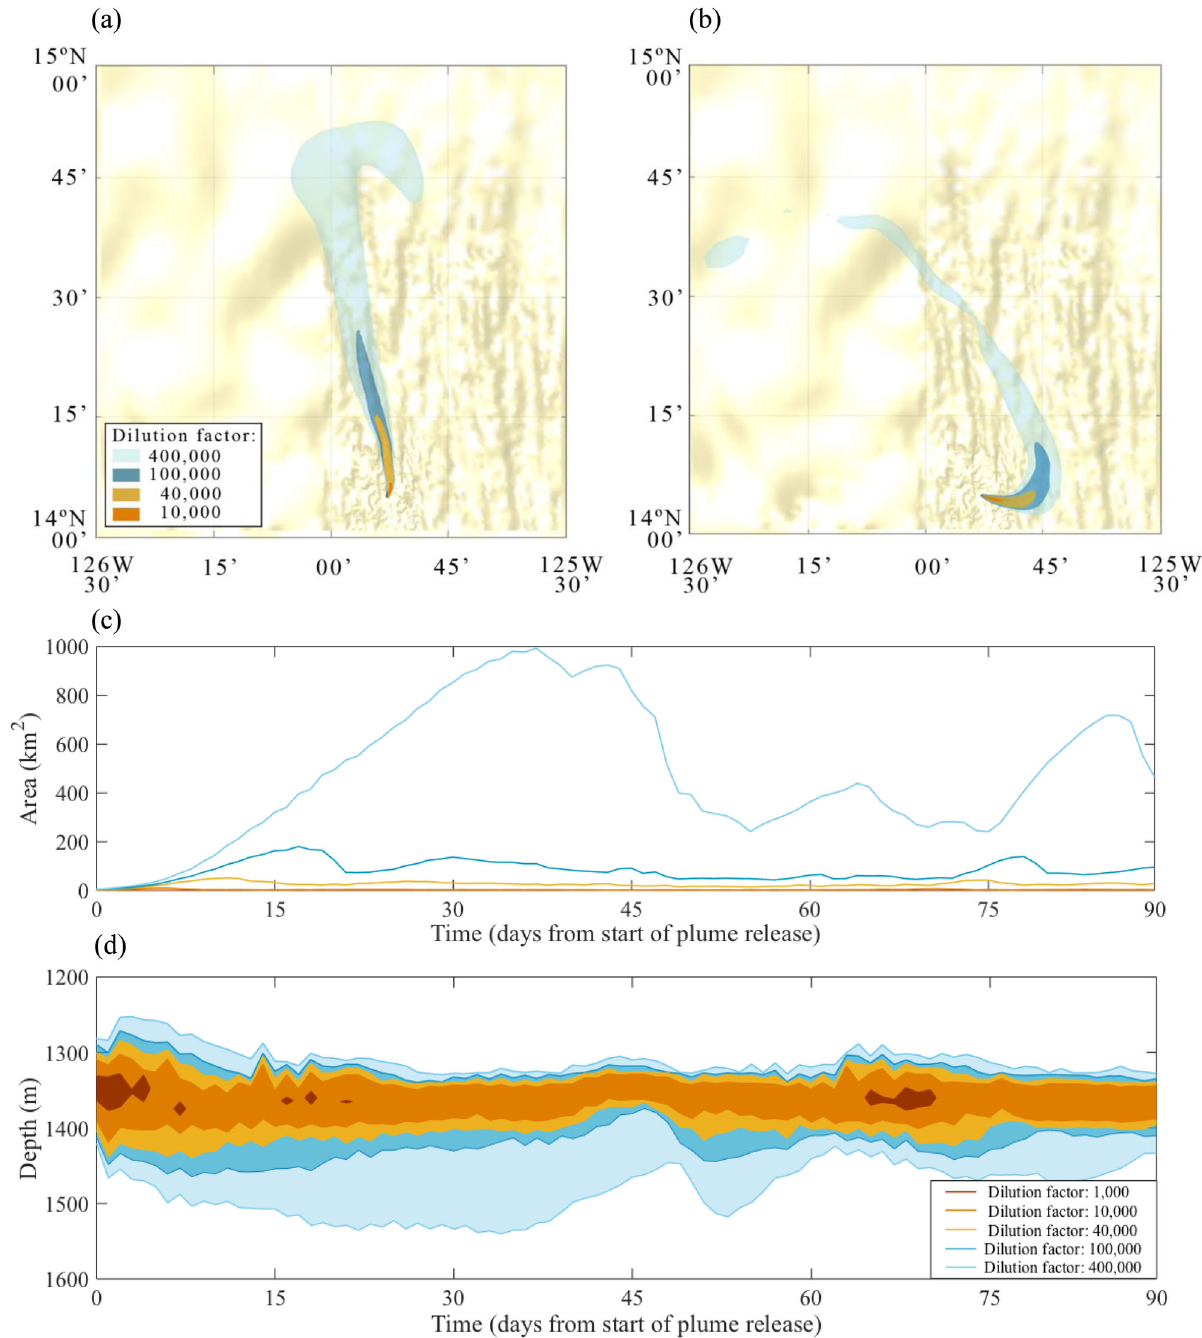
Fig. 7 TELEMAC numerical simulation of continuous commercial scale sediment plume release over 90 days. Top view of the 10,000 (orange), 40,000 (yellow), 100,000 (dark blue) and 400,000 (light blue) dilution factor contours of the plume for a a prevalent current (day 36 of the simulation) and b a current transition (day 88 of the simulation). These contours show the maximum horizontal extent of each 3D contour level and are not a cross section at a speci fi c depth. c Horizontal projected area of the plume dilution factor contours. d Maximum vertical extent of the plume across the entire domain as a function of time. The current velocity and direction at the location and depth of the discharge can be found in Supplementary Fig.